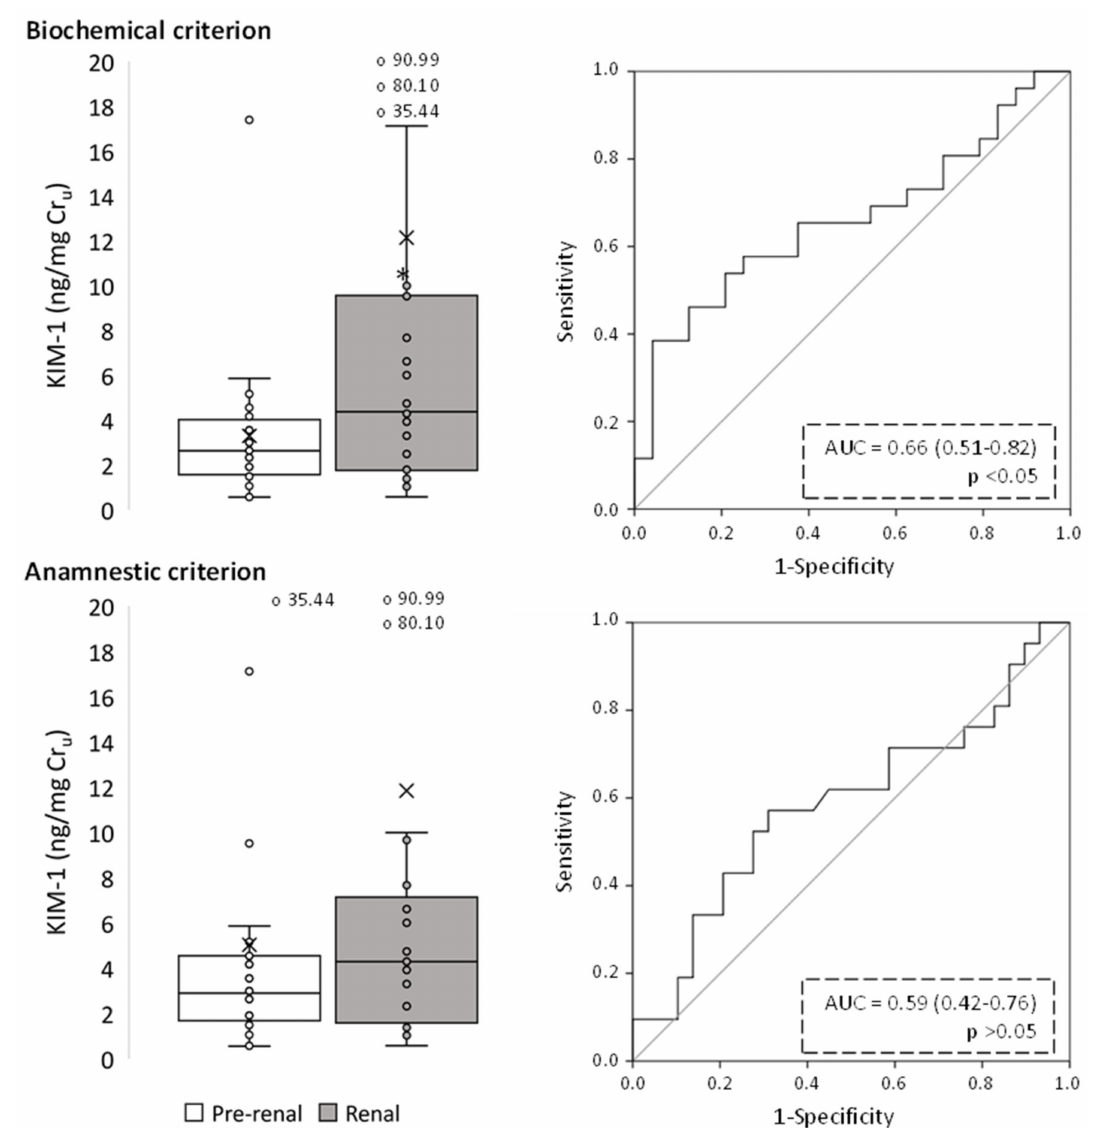
Figure 3. Urinary KIM-1 levels of pre-renal and renal AKI patients following classification by biochemical and anamnestic criteria, shown as box plots ( left panels) representing median values in ng of urinary KIM-1 per mg urinary creatinine (Cr u ), and ROC curves ( right panels). AUC: area under the ROC curve showing the pre-renal/renal classification efficacy of urinary KIM-1. The × in box plots represents the median value. *, p <